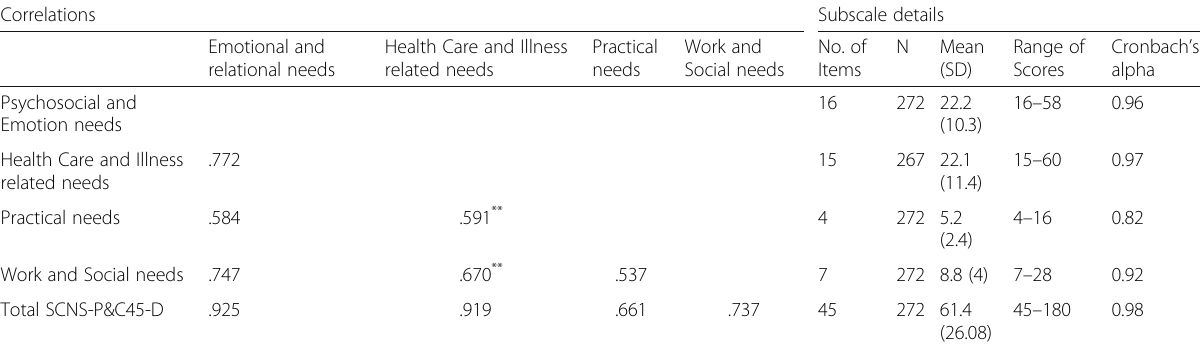
Table 2 Intercorrelations between SCNS-P&C45-D subscales and total SCNS-P&C45-D score, no. of items, mean (SD), Cronbach ’ s alpha and percentage of variance